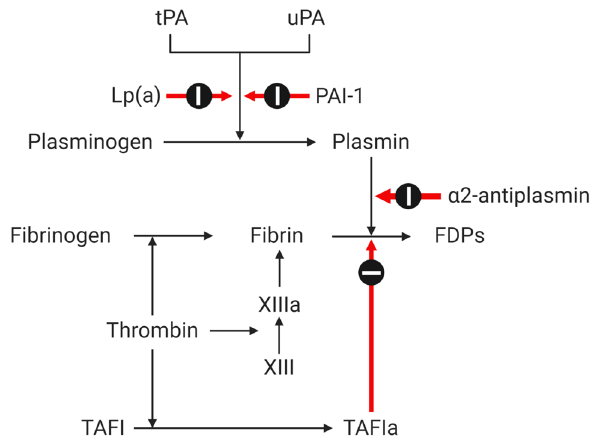
Fig. 3 Effects of different factors on the process of fibrinolysis. FDP—fibrin degradation product, Lp(a)—Lipoprotein A, PAI-1— plasminogen activator inhibitor 1, TAFI—thrombin activatable fibrinolysis inhibitor, tPA—tissue plasminogen activator, uPA— urokinase plasminogen